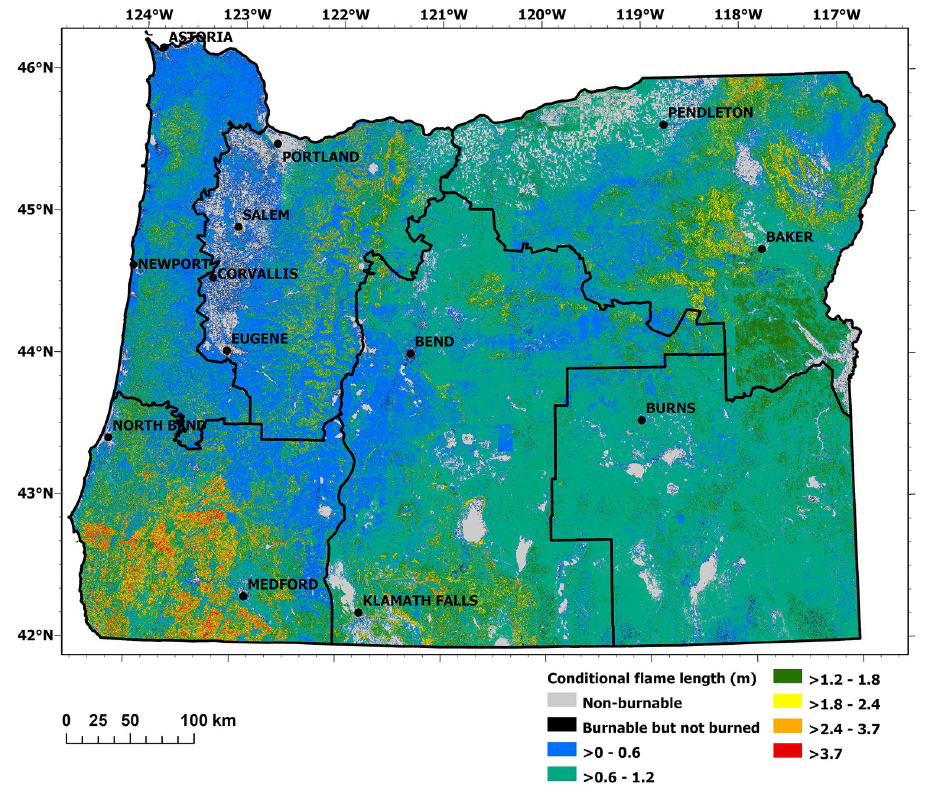
Fig 4. Conditional flame length modeled for each